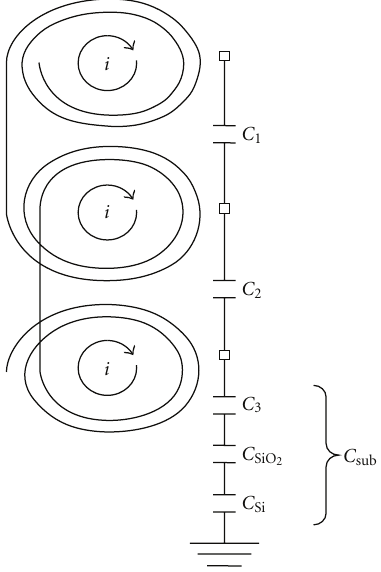
Figure 3: Schematic of triple-layer, stacked